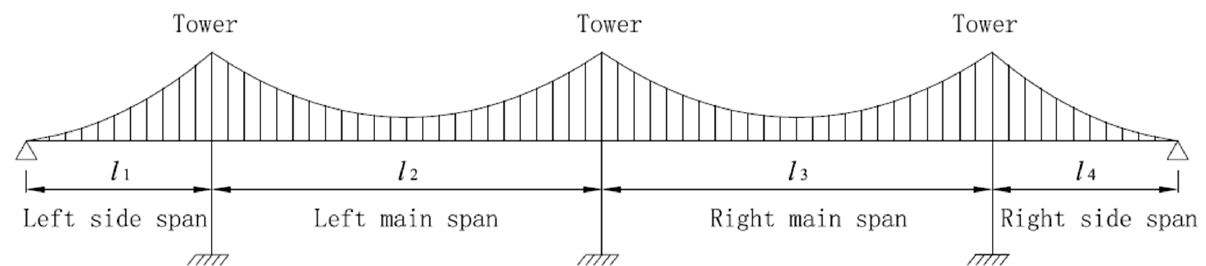
Figure 1. Schematic diagram of three-tower self-anchored suspension bridge.